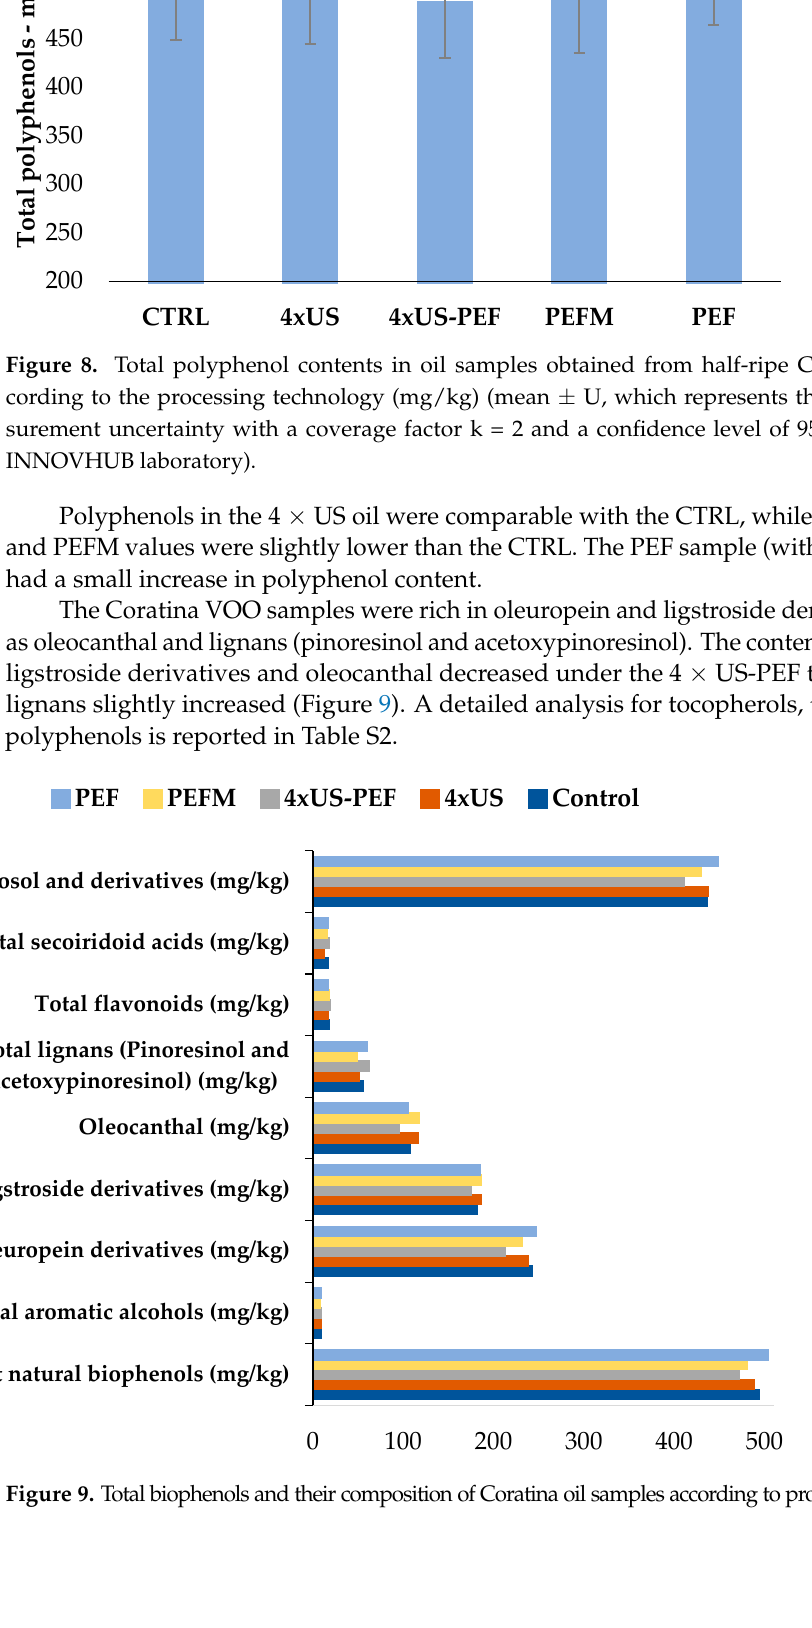
Figure 7. Tocotrienol contents in oil samples obtained from half-ripe Coratina olives according to processing technology (mg/kg).